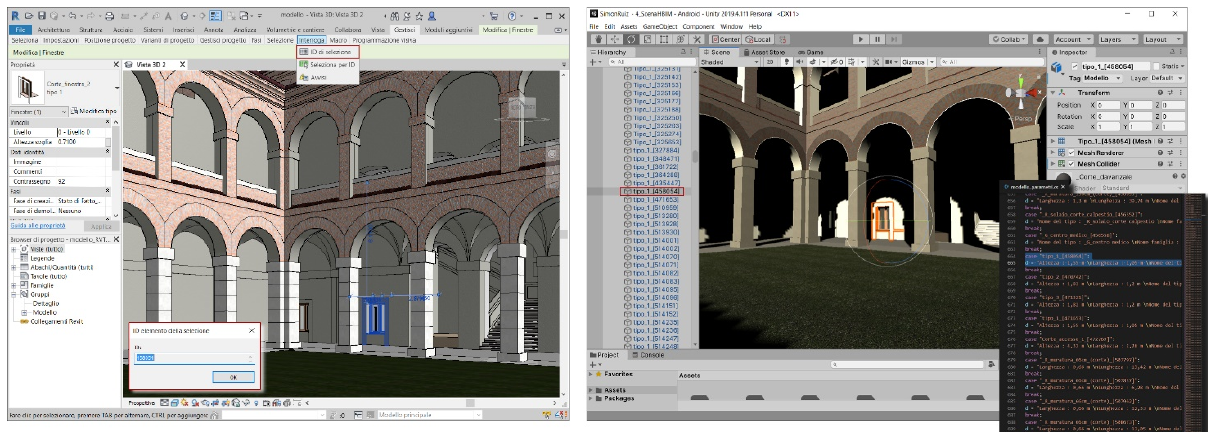
Figure 12: Correspondence in the ID code of the smart-objects read in Autodesk Revit , of the same object in Unity 3D and of the relative line of code in the parameter